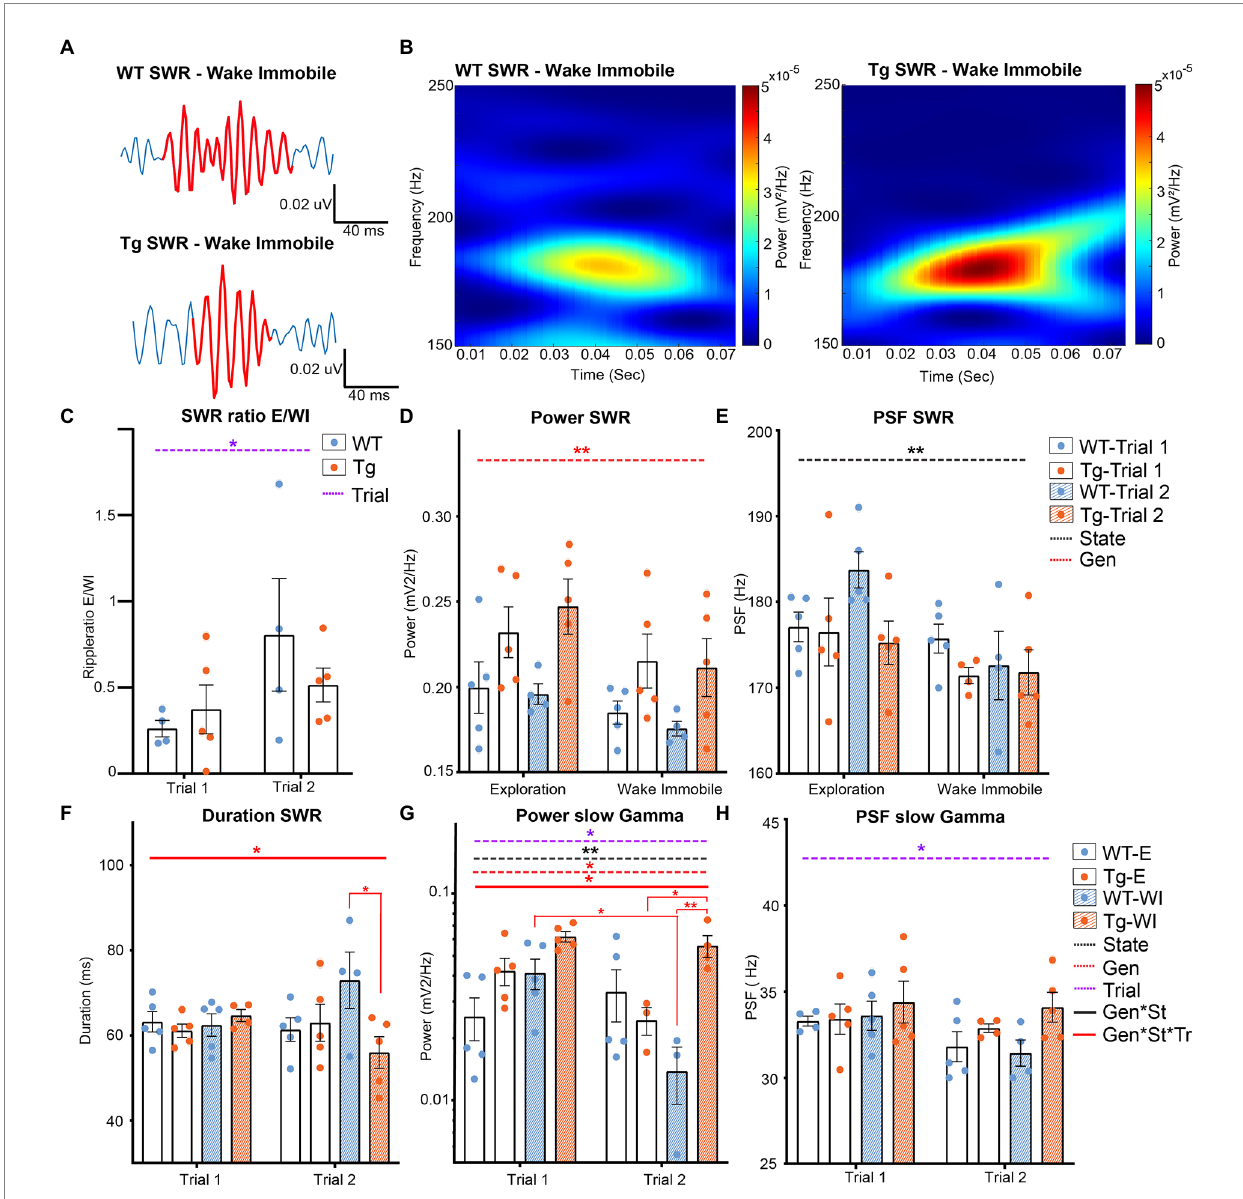
FIGURE 4 Analysis of different parameters for SWR in TgF344-AD rats during exploration and wake immobility. (A) Illustrative traces of bandpass filtered SWR (120–250 Hz) during wake immobility and corresponding time-frequency plot (B) demonstrating the power of the ripple oscillation at different frequencies over time for the wildtype (WT) and TgF344-AD (Tg) rat. (C) SWR occurrences ratio between exploratory/wake immobility for each animal. (D) The mean power within the SWR frequency band for each behavioral state. (E) Peak spectral frequency of the SWR for each behavioral state. (F) Duration of SWR in milliseconds (ms) separated for each trial. (G) The power of slow gamma oscillations during SWR was separated for each trial. (H) The peak spectral frequency of slow gamma during exploration and wake immobility separated for each trial. Bars represent mean ± SEM, individual values are represented by the dots. * p ≤ 0.05/ q ≤ 0.01, ** p ≤ 0.01/ q ≤